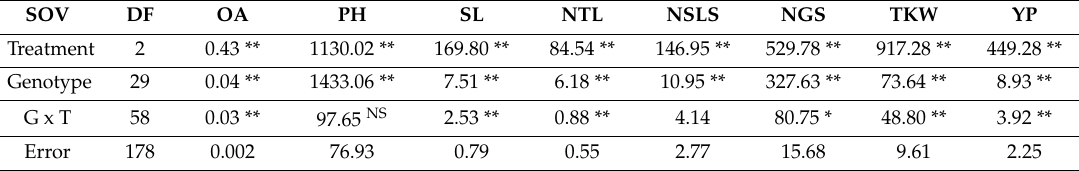
Table 2. Analysis of variance (MS values) for all the traits under WW and DS conditions.